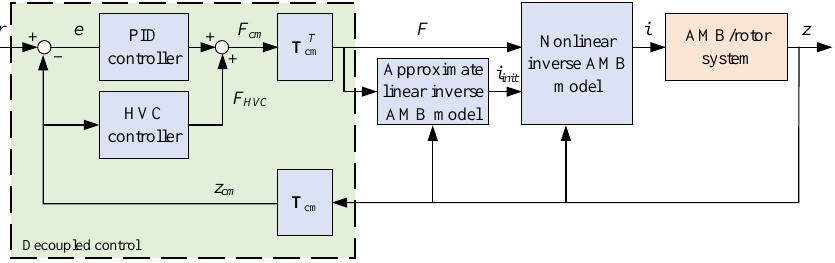
Figure 10. Decoupled feedback control scheme with exact linearization.